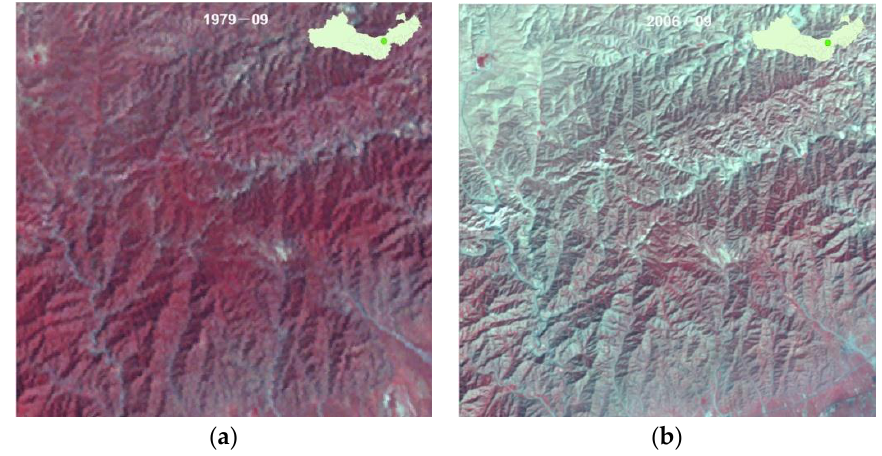
Figure 10. The significant negative changes of vegetation production by human activities in the middle of Inner Mongolia Province: ( a ) MSS image in September 1977; and ( b ) TM image in September 2006.